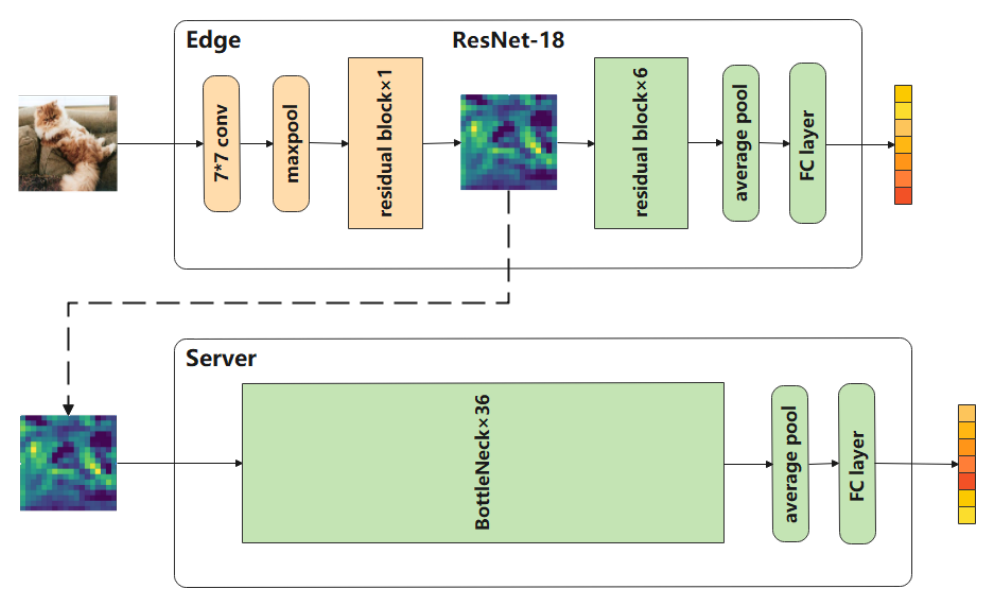
Figure 3. CNN architectures on the edge and